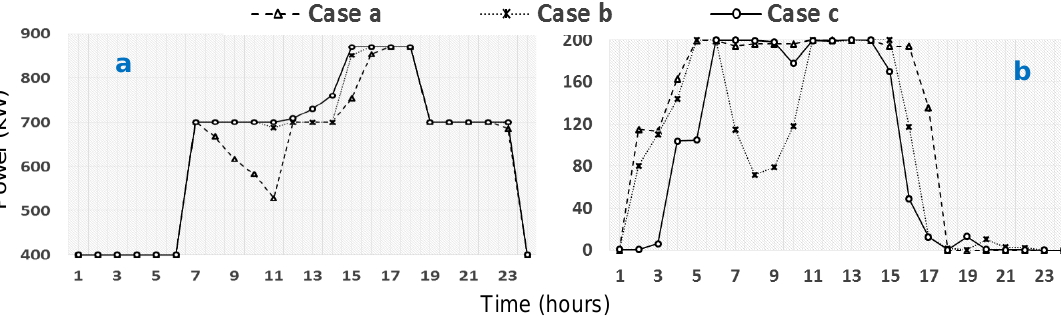
Figure 12. Grid-connected mode: ( a ) Collective generation amount of CGs; and ( b ) Cumulative SOC of BESSs.